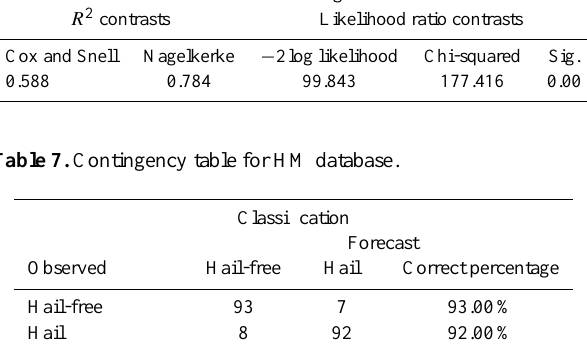
Table 8. Average results of algorithms for the 26 events of each type included in the verification database. CM shows cumulonim- bus probability and HM hail precipitation